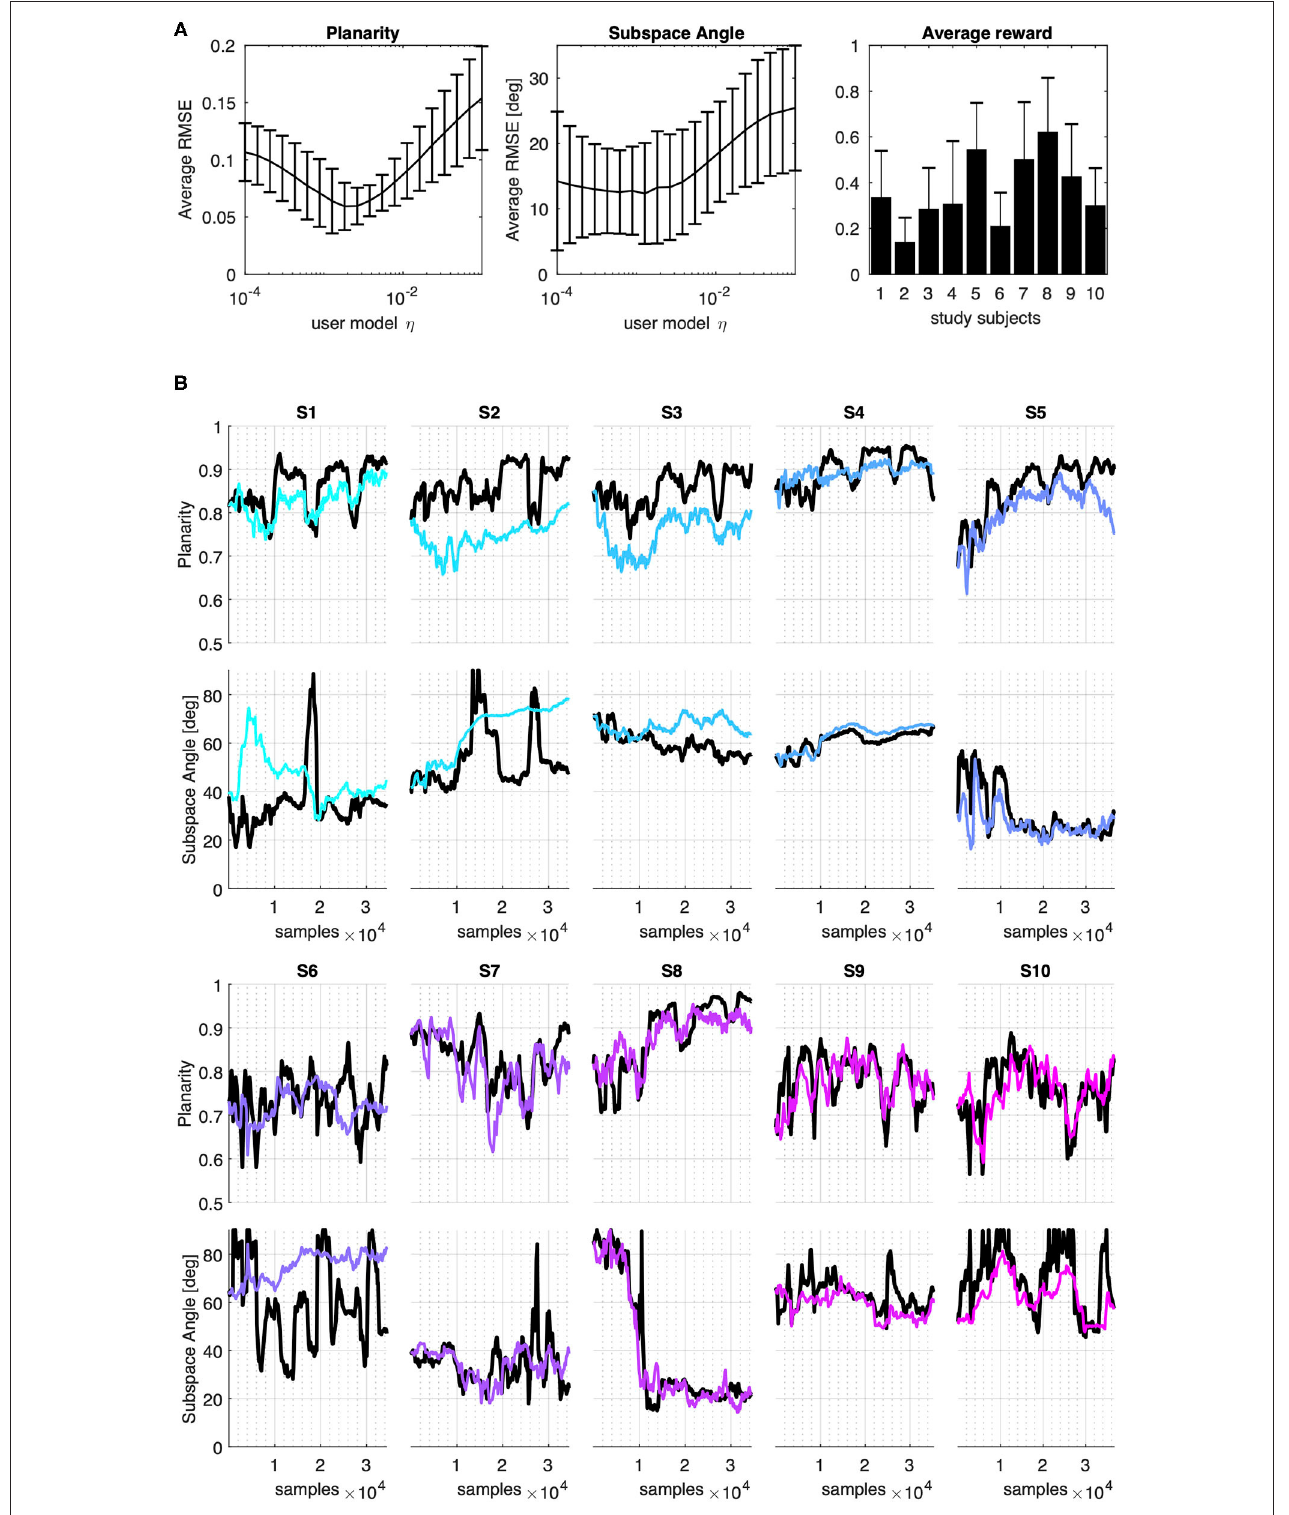
FIGURE 3 | Model prediction of experimental data. Planarity and Subspace Angle estimated from the data of 10 study participants from De Santis and Mussa-Ivaldi (2020) (A) : from left to right, average performance of the model vs. experimental datasets in terms of Root Mean Squared Error (RMSE) on Planarity and Subspace Angle metrics and the average reward computed over the dataset given the user interface map. (B) Model performance across iterations. Metrics computed on the experimental data are reported in black solid lines. Colored lines represent the values obtained from the data distribution generated iteratively by one out of 20 models with varying learning rates that have been trained with experimental data. The selected models in the figure have learning rate of 0.0013.